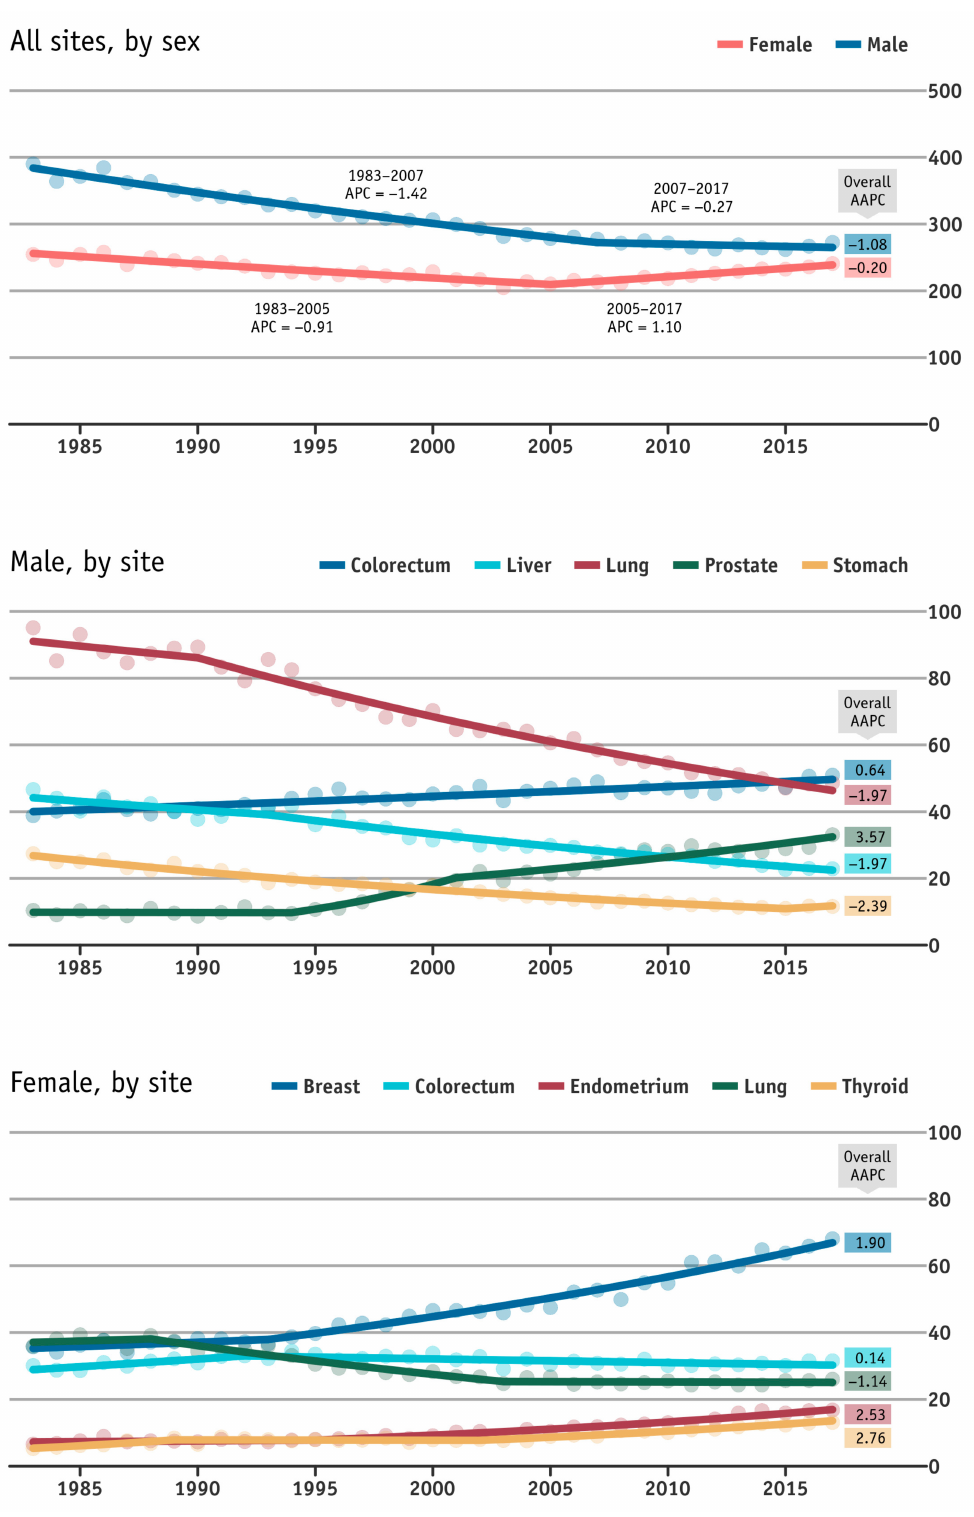
Figure 1. Annual age-standardised incidence rates for top five male/female cancers in Hong Kong from 1983 to 2017. The rates are age-adjusted according to the WHO standard population in 2000. Top five cancers are based on the figures from the Hong Kong Cancer Registry in 2017. (NB: average annual percentage change = AAPC; annual percentage change =